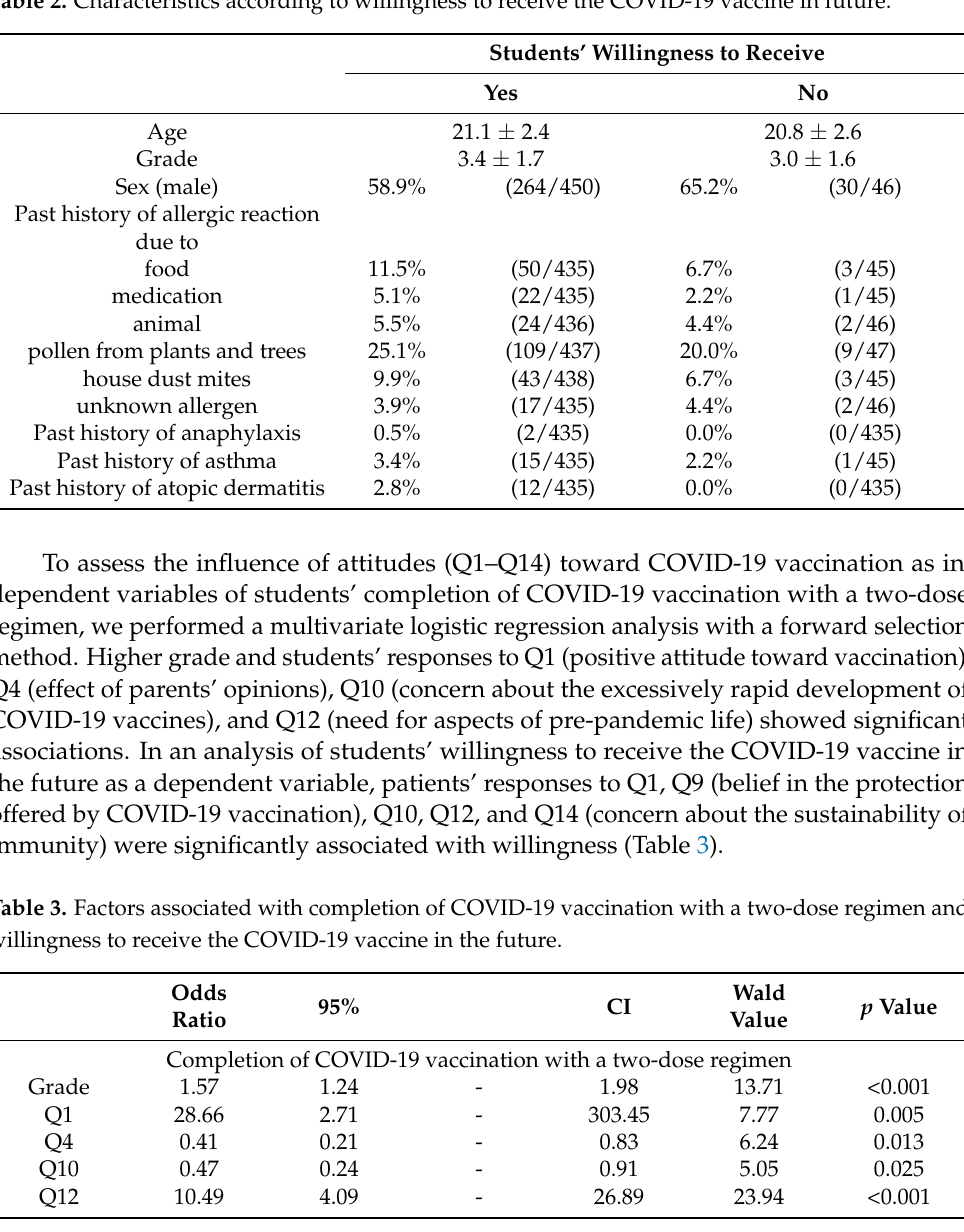
Table 2. Characteristics according to willingness to receive the COVID-19 vaccine in future.